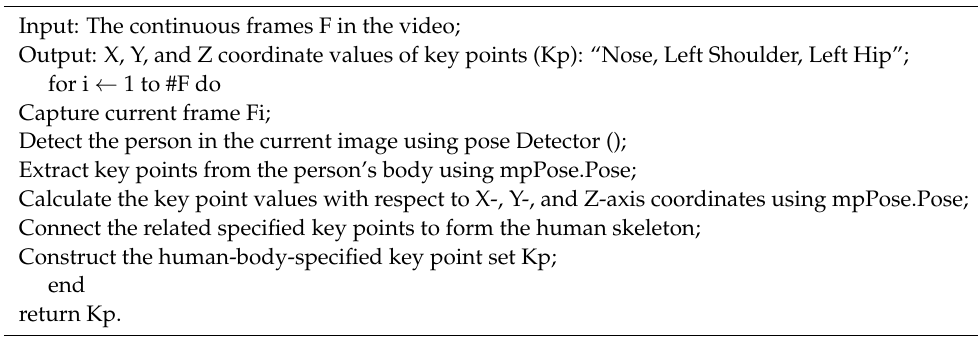
Algorithm 1. Key point detection algorithm on the human body using Media Pipe